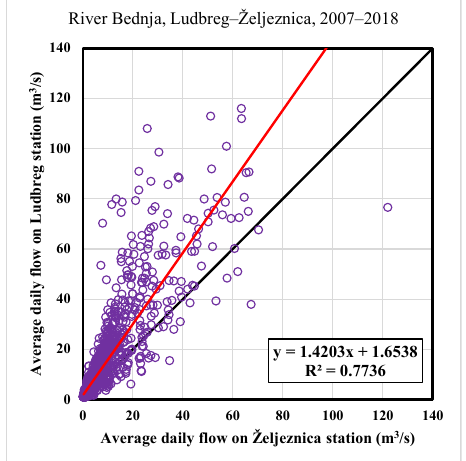
Figure 7. Comparison of the correlation between the measuring stations Ludbreg and Željeznica.